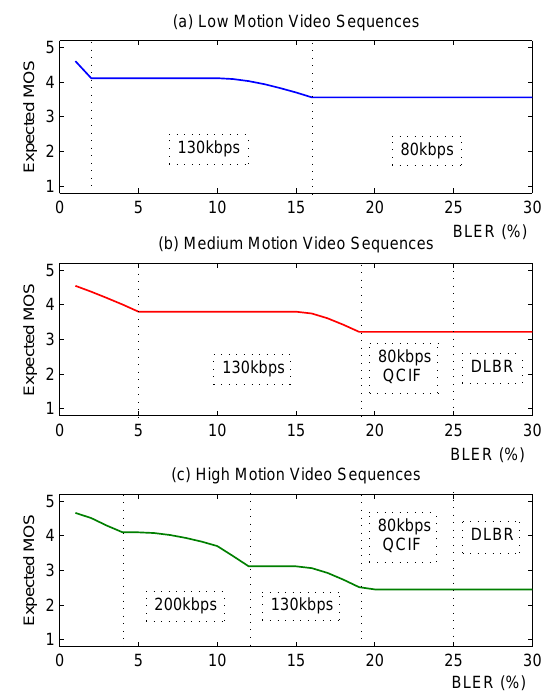
Figure 6. Dynamic configuration and maximum achievable quality for (a) low motion, (b) medium motion, (c) high motion sequences.